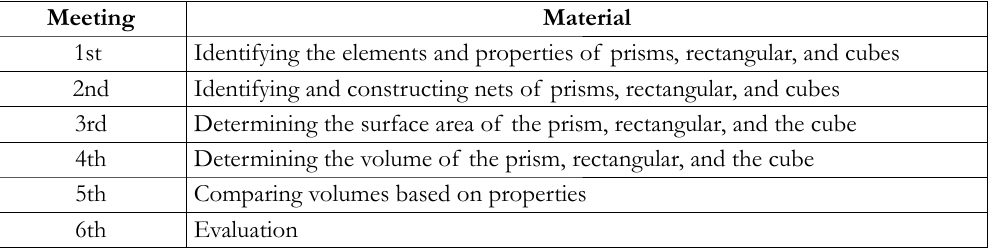
Table 1. Distribution of